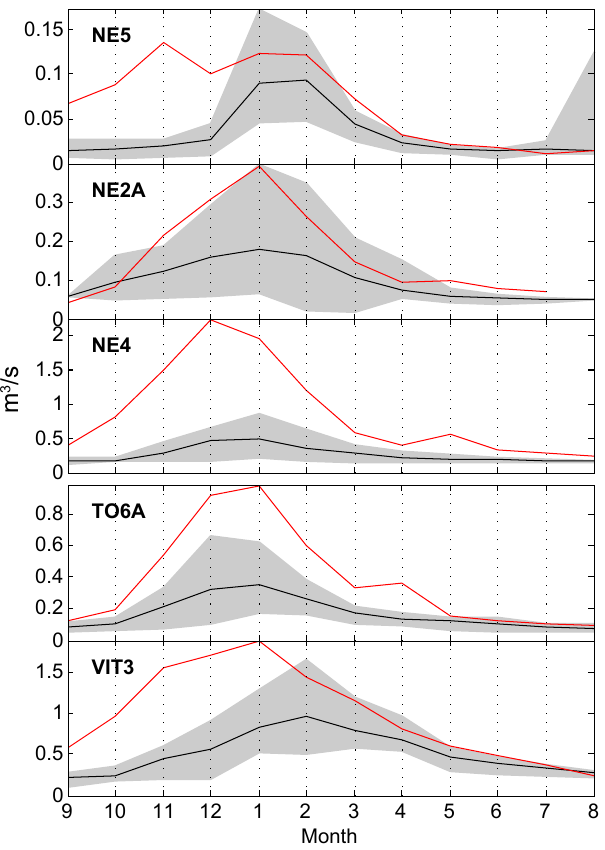
Fig. 8. Impact of El Ni˜no on the hydrological regime. Black line: mean monthly discharge (2003/2004–2007/2008). Shaded: range of monthly discharges over the same period. Red line: monthly dis- charge in 2002/2003 (El Ni˜no year). Note: NE-5 monthly discharge range is affected by a summertime rainfall event which occurred in August 2008 (example of an Altiplano winter event, see Sect. 2).